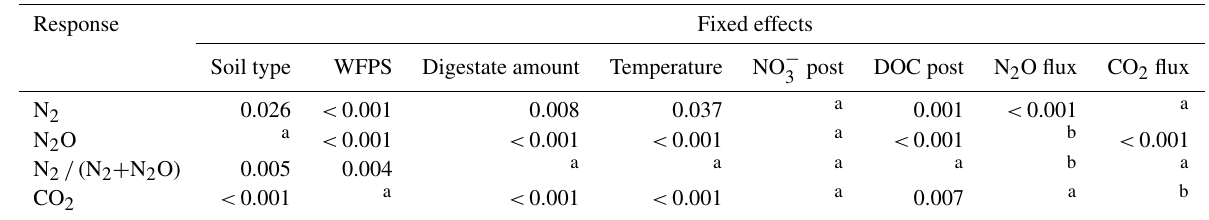
Table 5. ANOVA table (type 2, p values calculated based on Satterthwaite’s approximation) of the linear mixed-effect models for